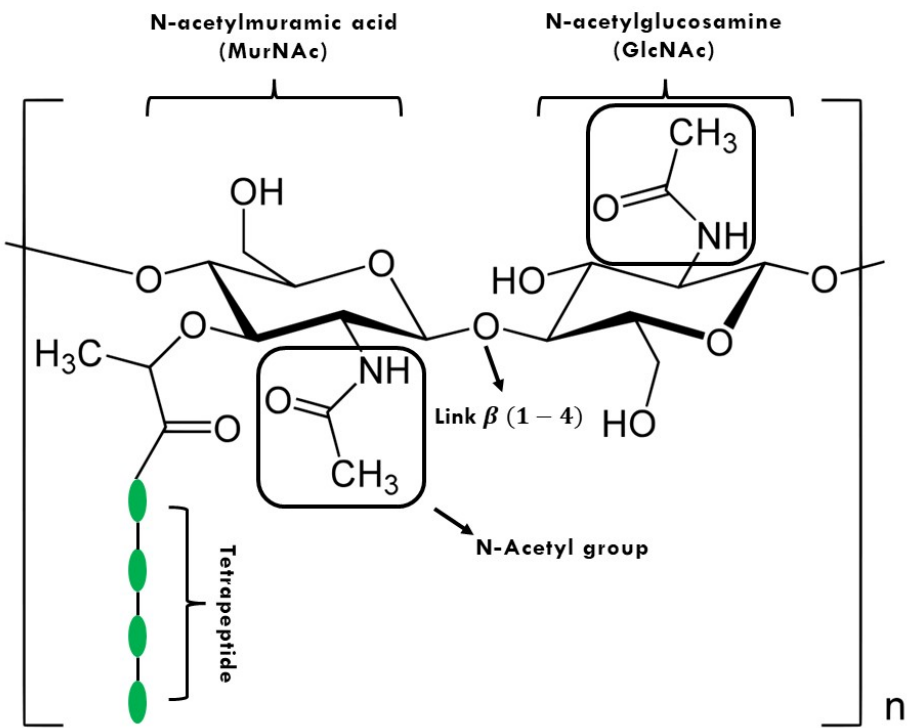
Figure 1. Peptidoglycan (PG) structure. The letter n means the repetition of the structure “n” times.